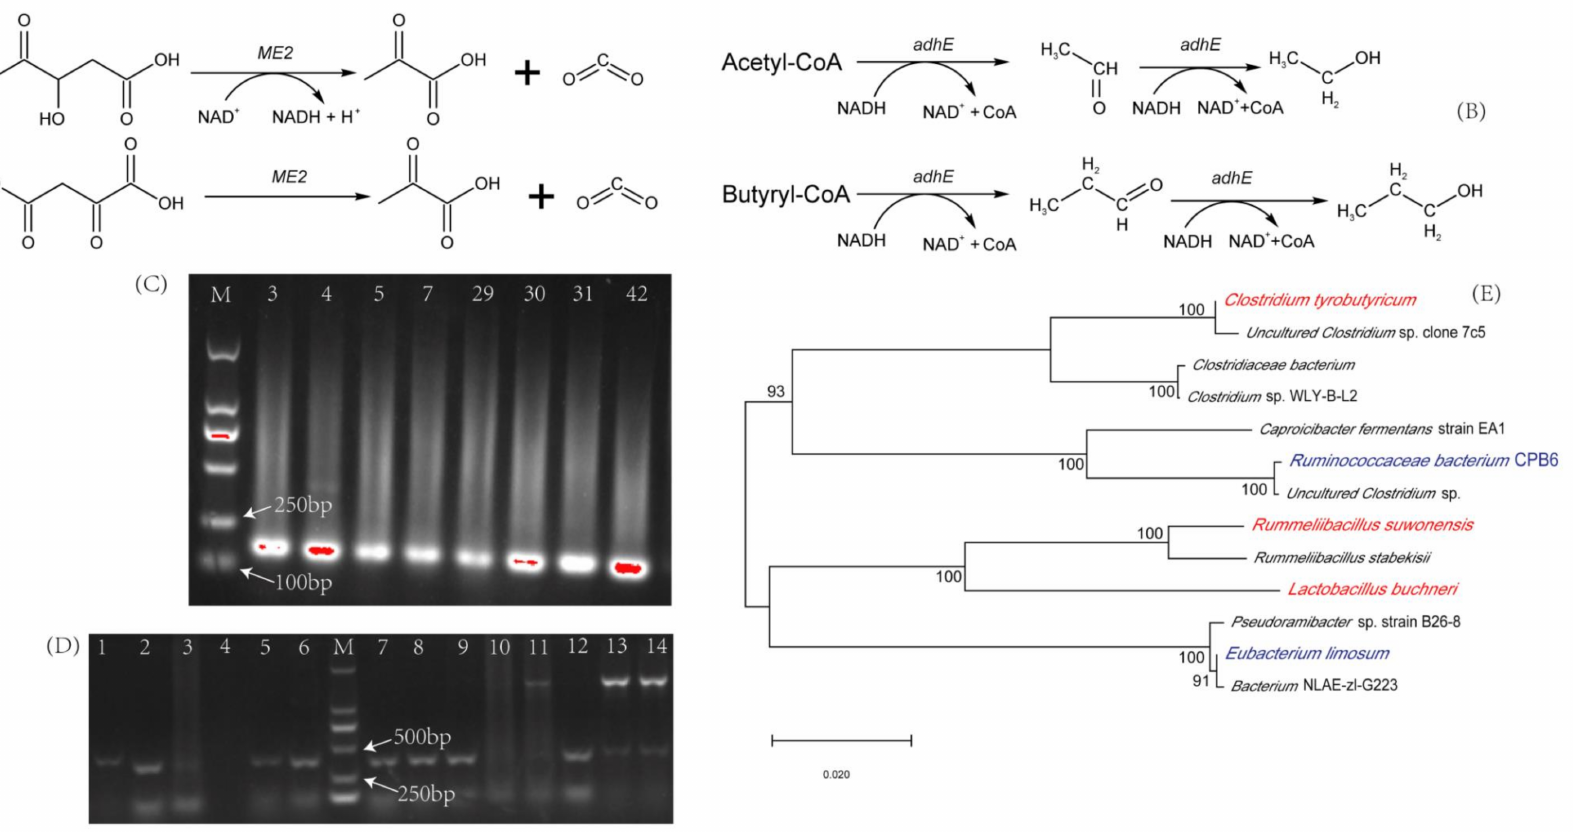
Figure 1. ( A ) The two biochemical reactions catalyzed by malate dehydrogenase (enzyme expressed by gene ME2 ); ( B ) The two biochemical reactions catalyzed by acetaldehyde dehydrogenase (enzyme expressed by gene adhE ); ( C ) Agarose gel electrophoresis of the products of colony PCR based on gene ME2 ; ( D ) Agarose gel electrophoresis of the products of colony PCR based on gene adhE ; ( E ) Phylogenetic tree of the functional microorganisms based on 16S rDNA gene